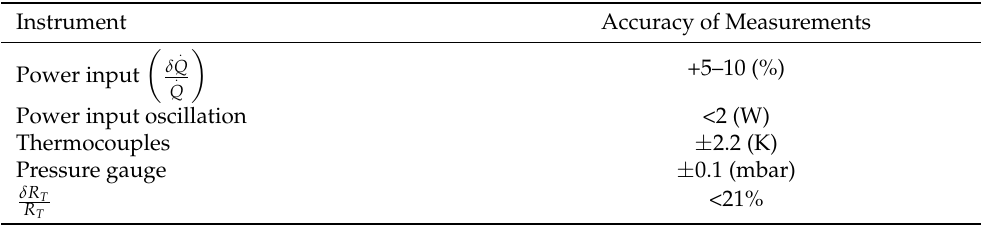
Table 2. Accuracy of measurement instruments and uncertainty of